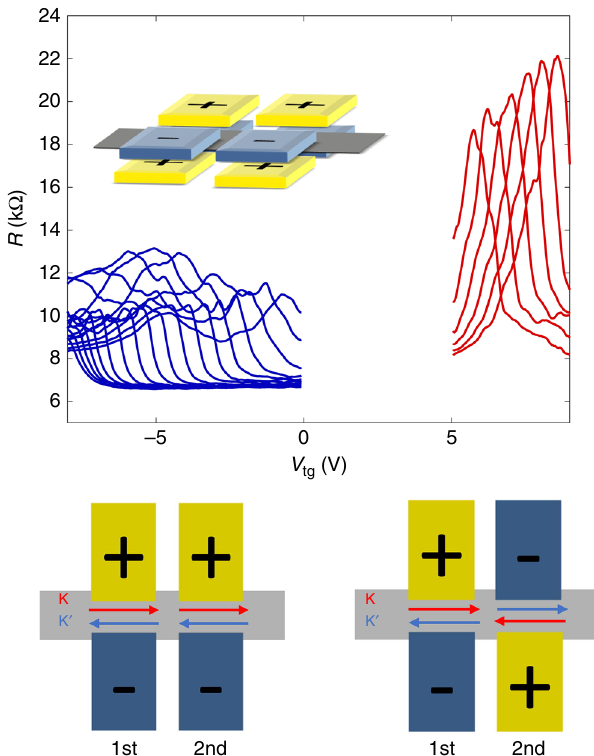
Fig. 5 Demonstration of chiral nature: valley analyzer measurement with two gate pairs in same (left) or opposite (right) valley-polarized state. Gate con fi gurations are shown underneath. During the measurement, the fi rst gate pair is kept at constant voltages to maintain in a fi xed valley- polarized state. One half of the second gate pair is fi xed too and only one top gate and one bottom gate is scanned (similar scheme to Figs. 3 and 4). The BLG resistance as function displays two different regimes: high (low) resistance states are observed under opposite (same) valley-polarized state of two gate pairs, indicating the chiral nature of states in odd-gate con fi guration. The insets above measurement curves show exemplary 3D side view of gate con fi